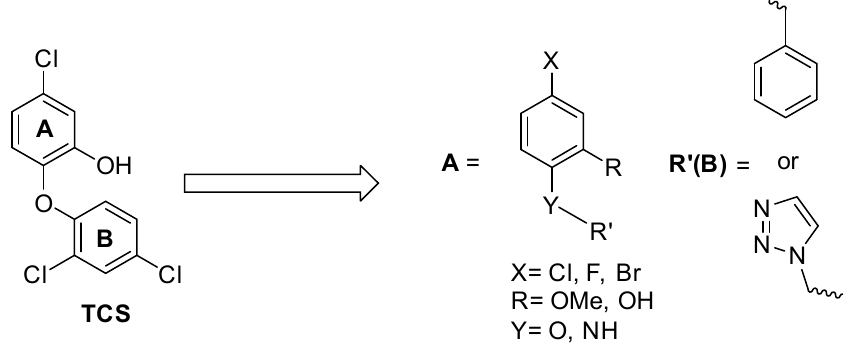
Figure 3. Overall target summary .